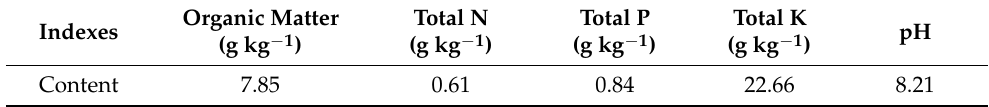
Figure 1. Precipitation and temperature during the soybean cropping season. ( A ), the cropping season of 2019; ( B ), the cropping season of 2020. Table 1. The soil’s physical and chemical properties.